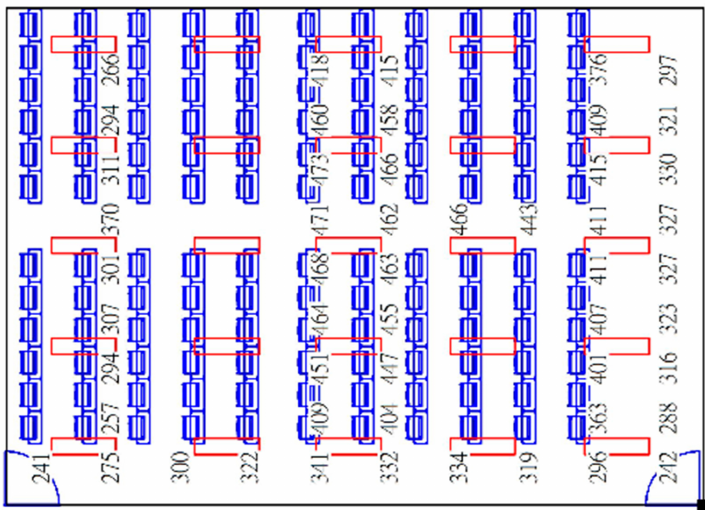
Figure 11. Illuminance distribution before lighting